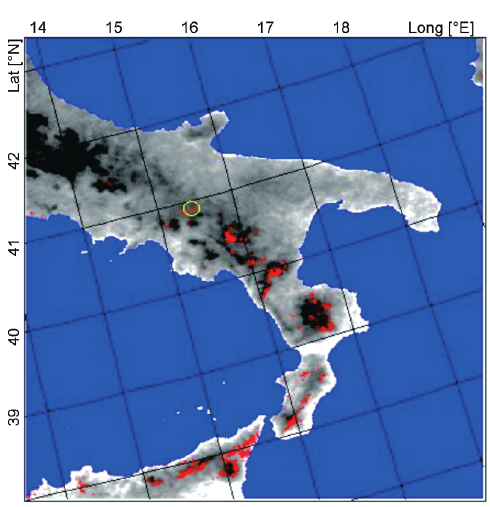
Fig. 3. Irpinia-Basilicata earthquake ( M S = 6.9, No- vember, 23, 1980, 7.32 p.m.): analysis in the tempo- ral domain over the extended study area for Novem- ber 1980. Thermally anomalous area is depicted in red tones. The circle represents the epicentral zone (from Tramutoli et al. ,